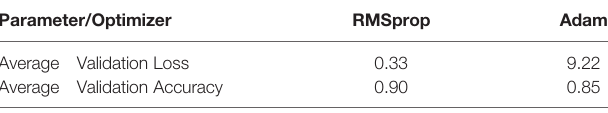
TABLE 2 | Comparison of the average validation loss and accuracy obtained by two optimizers.